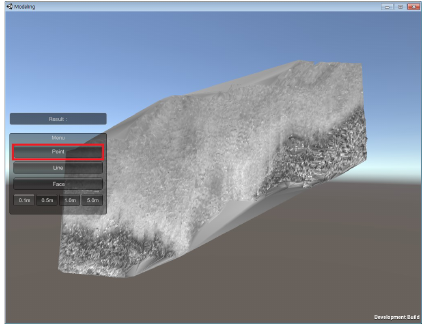
Figure 5. 3D Model